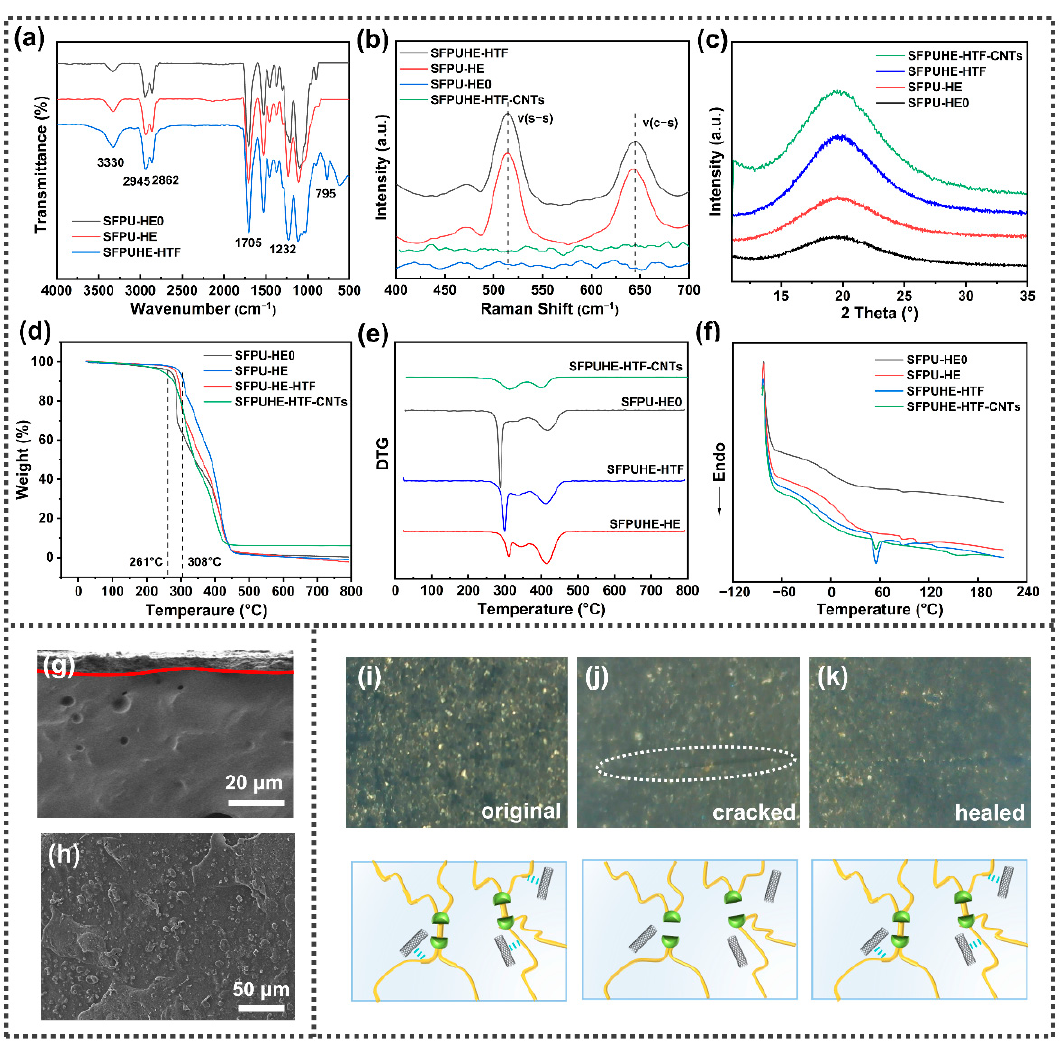
Figure 2. Structural characterization of self-healing polyurethanes: ( a ) FTIR spectra; ( b ) Raman spec- tra; ( c ) X-ray diffraction patterns; ( d ) thermogravimetric curves; ( e ) micro-quotient thermogravimetric curves; ( f ) DSC curves. The SEM images of the ( g ) cross section (500 × ) and ( h ) surface (1000 × ) mor- phology of SFPUHE-HTF-CNTs. ( i – k ) Self-healing process of SFPUHE-HTF-CNTs (photographed by microscope); the inset shows a schematic illustration of the healing mechanism.